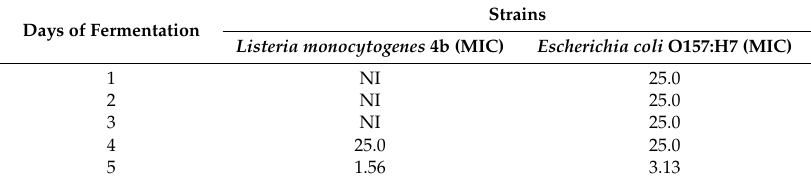
Table 1. Minimum inhibitory concentrations (MIC) of fermented whey to control two selected bacterial strains